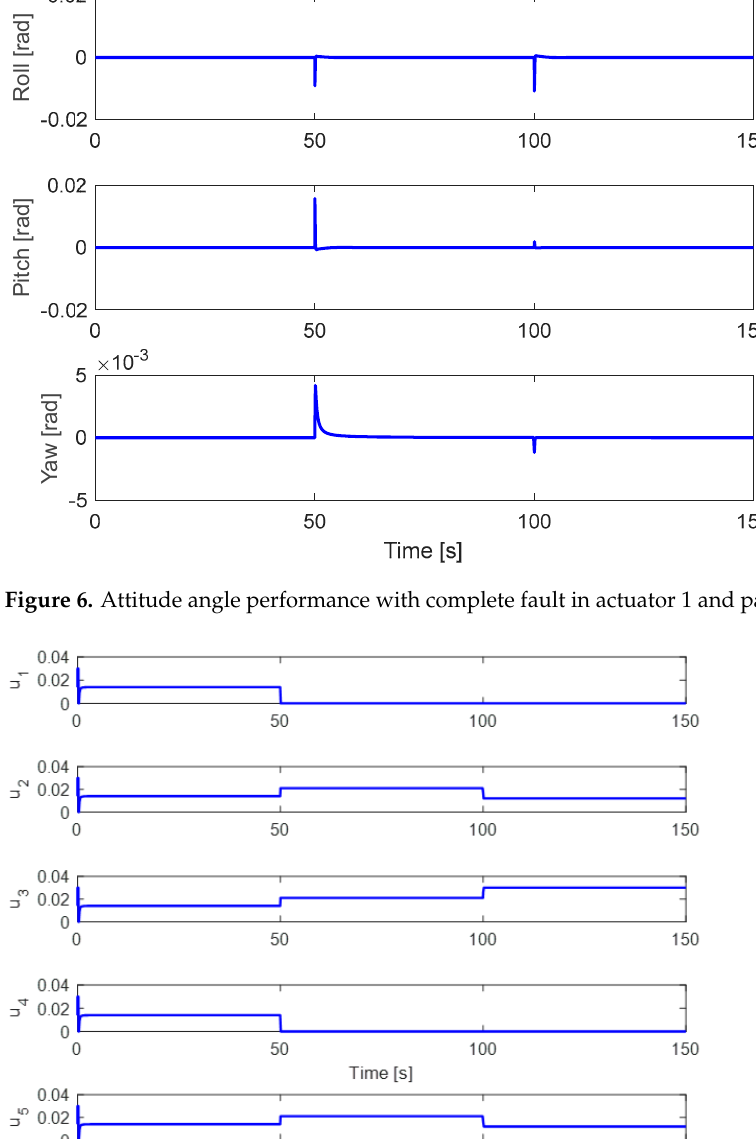
Figure 5. Altitude and position performance with complete fault in actuator 1 and partial fault in actuator 2.